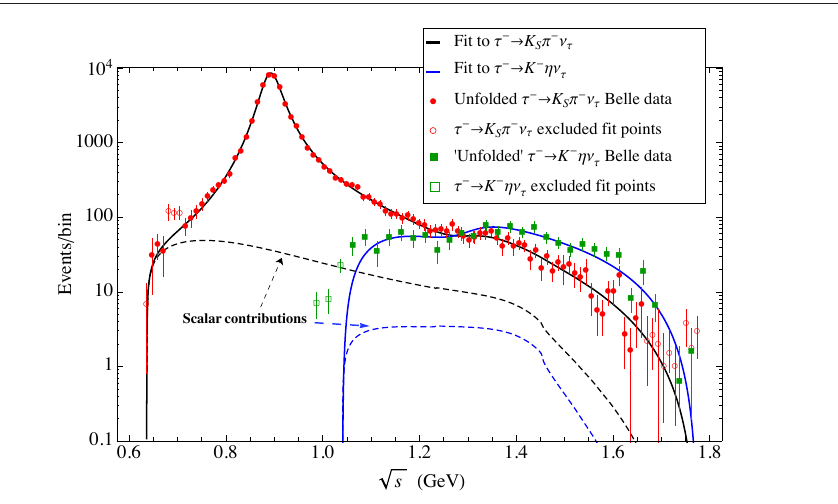
Figure 3. Belle τ − → K S π − ν τ (red circles) and τ − → K − ην τ (green squares) measurements as compared to our best results (solid black and blue curves, respectively) obtained in combined fits to both data sets.